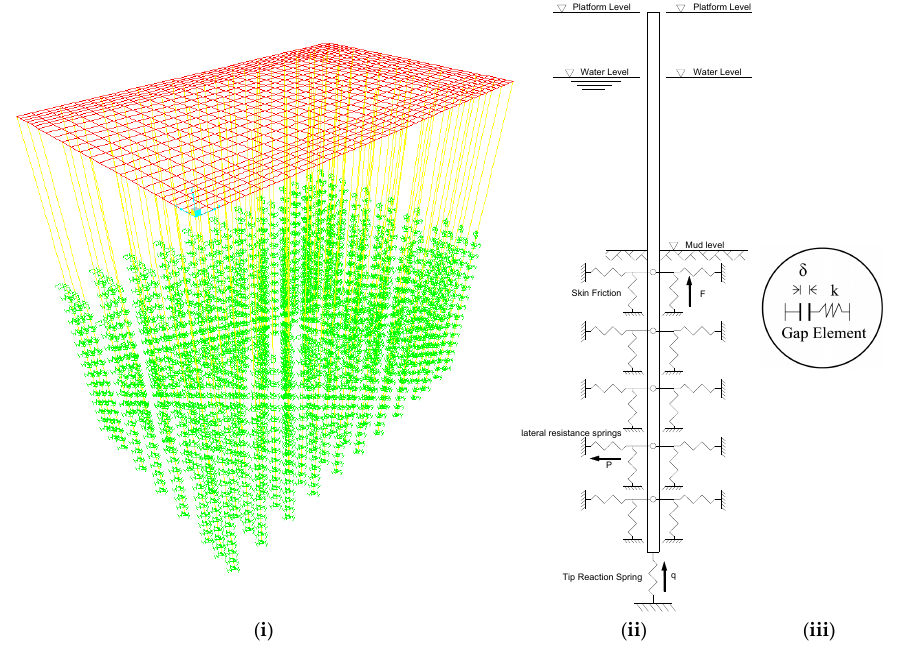
Figure 3. ( i ) The 3D finite element model used in SAP2000 v.17, ( ii ) Illustration of soil springs, and ( iii ) Spring-Gap element (at 1 m under bed level).